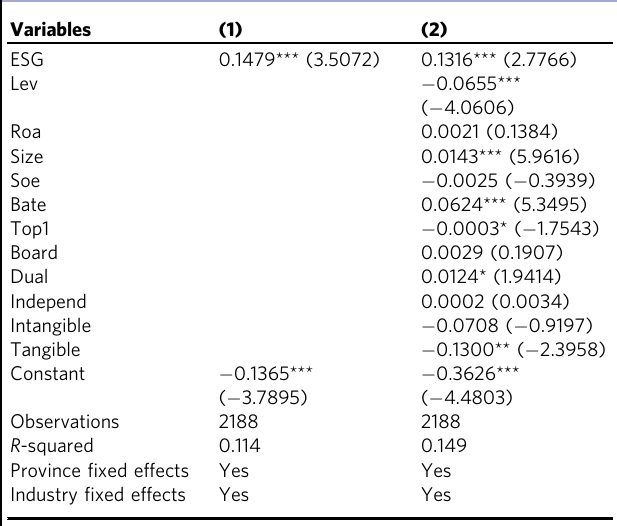
Table 3 Baseline results.